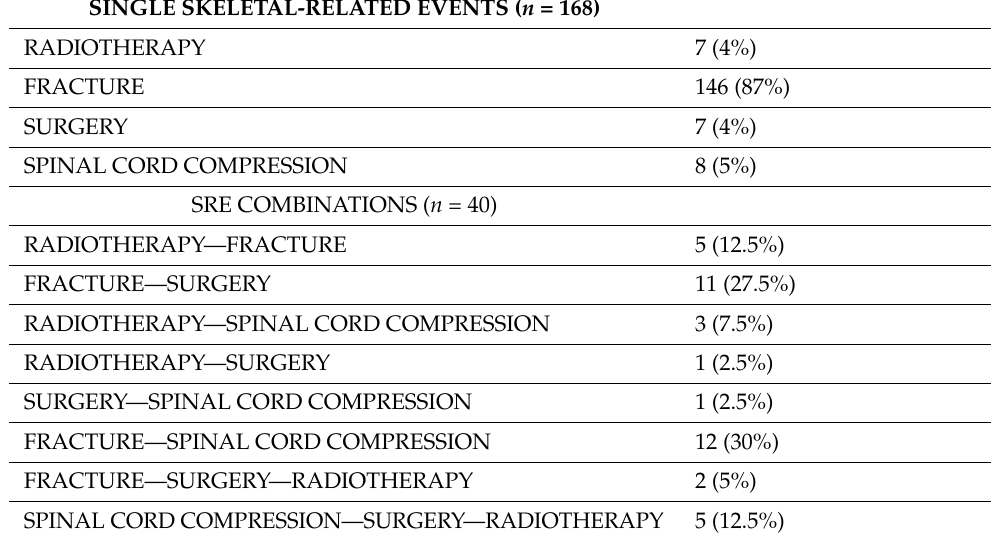
Table 3. Incidence of SREs at MM